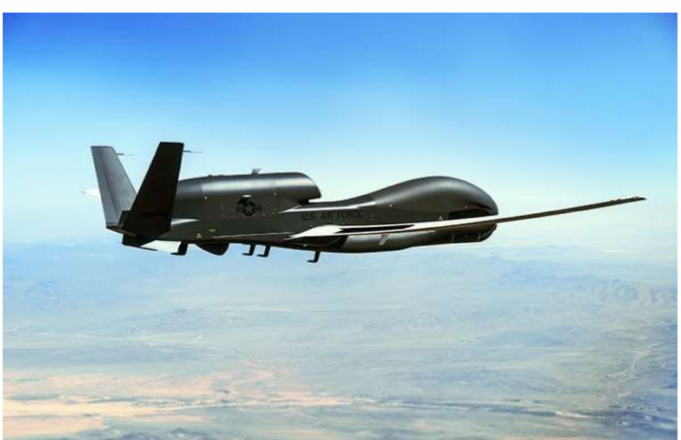
Figure 2. Example of a fixed-wing UAV: The Northrop Grumman RQ-4. Photo courtesy of Northrop Grumman